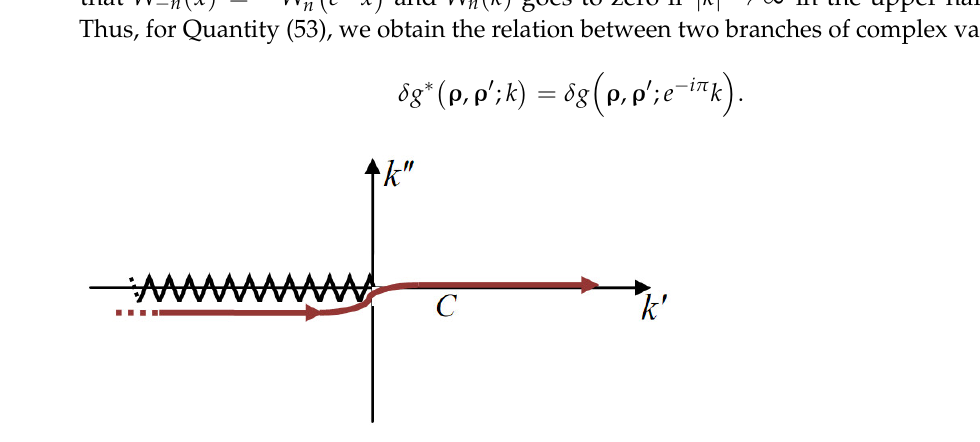
Figure 4. The contour C (colored brown) is the integration contour in Equation (56). The cut is placed along the negative semi-axis and shown by the jagged line.